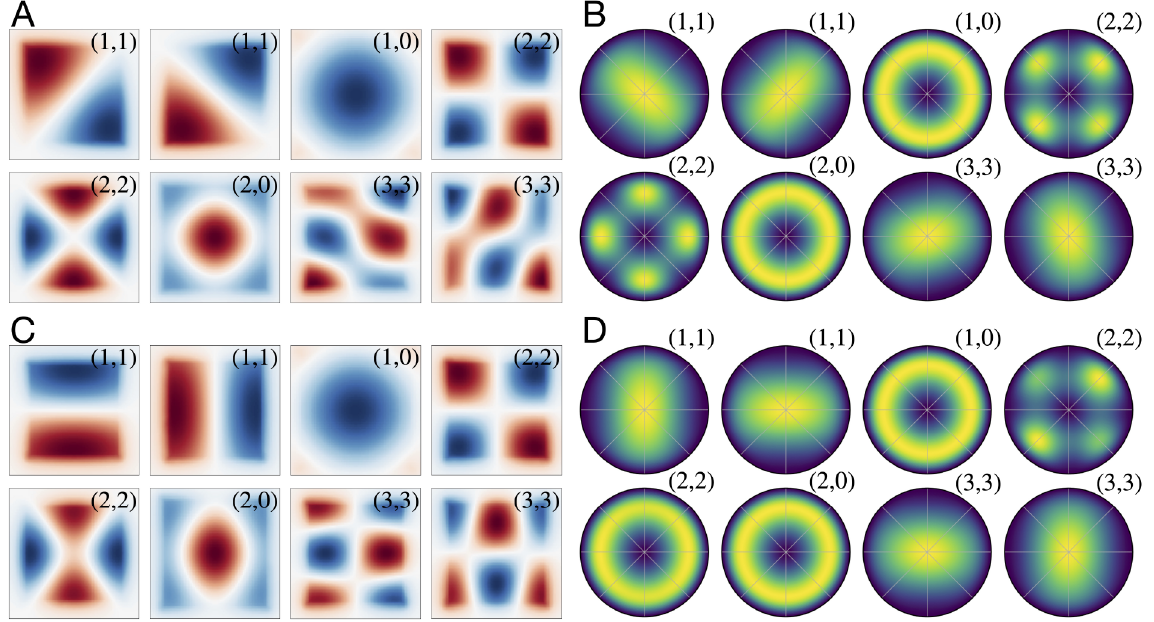
Fig. 4. QNMs of the RhoM geometry assembled on the (A,B) Sq04 and (C,D) Sq22 facets, ordered in increasing energy: (1,1), (1,1), (1,0), (2,2), (2,2), (2,0), (3,3), (3,3). A,C. Normalised QNM electric fi elds E z,lm in the xy -plane through the centre of the cavity. B,D. Time averaged far- fi eld Poynting fl ux 〈 S lm i .